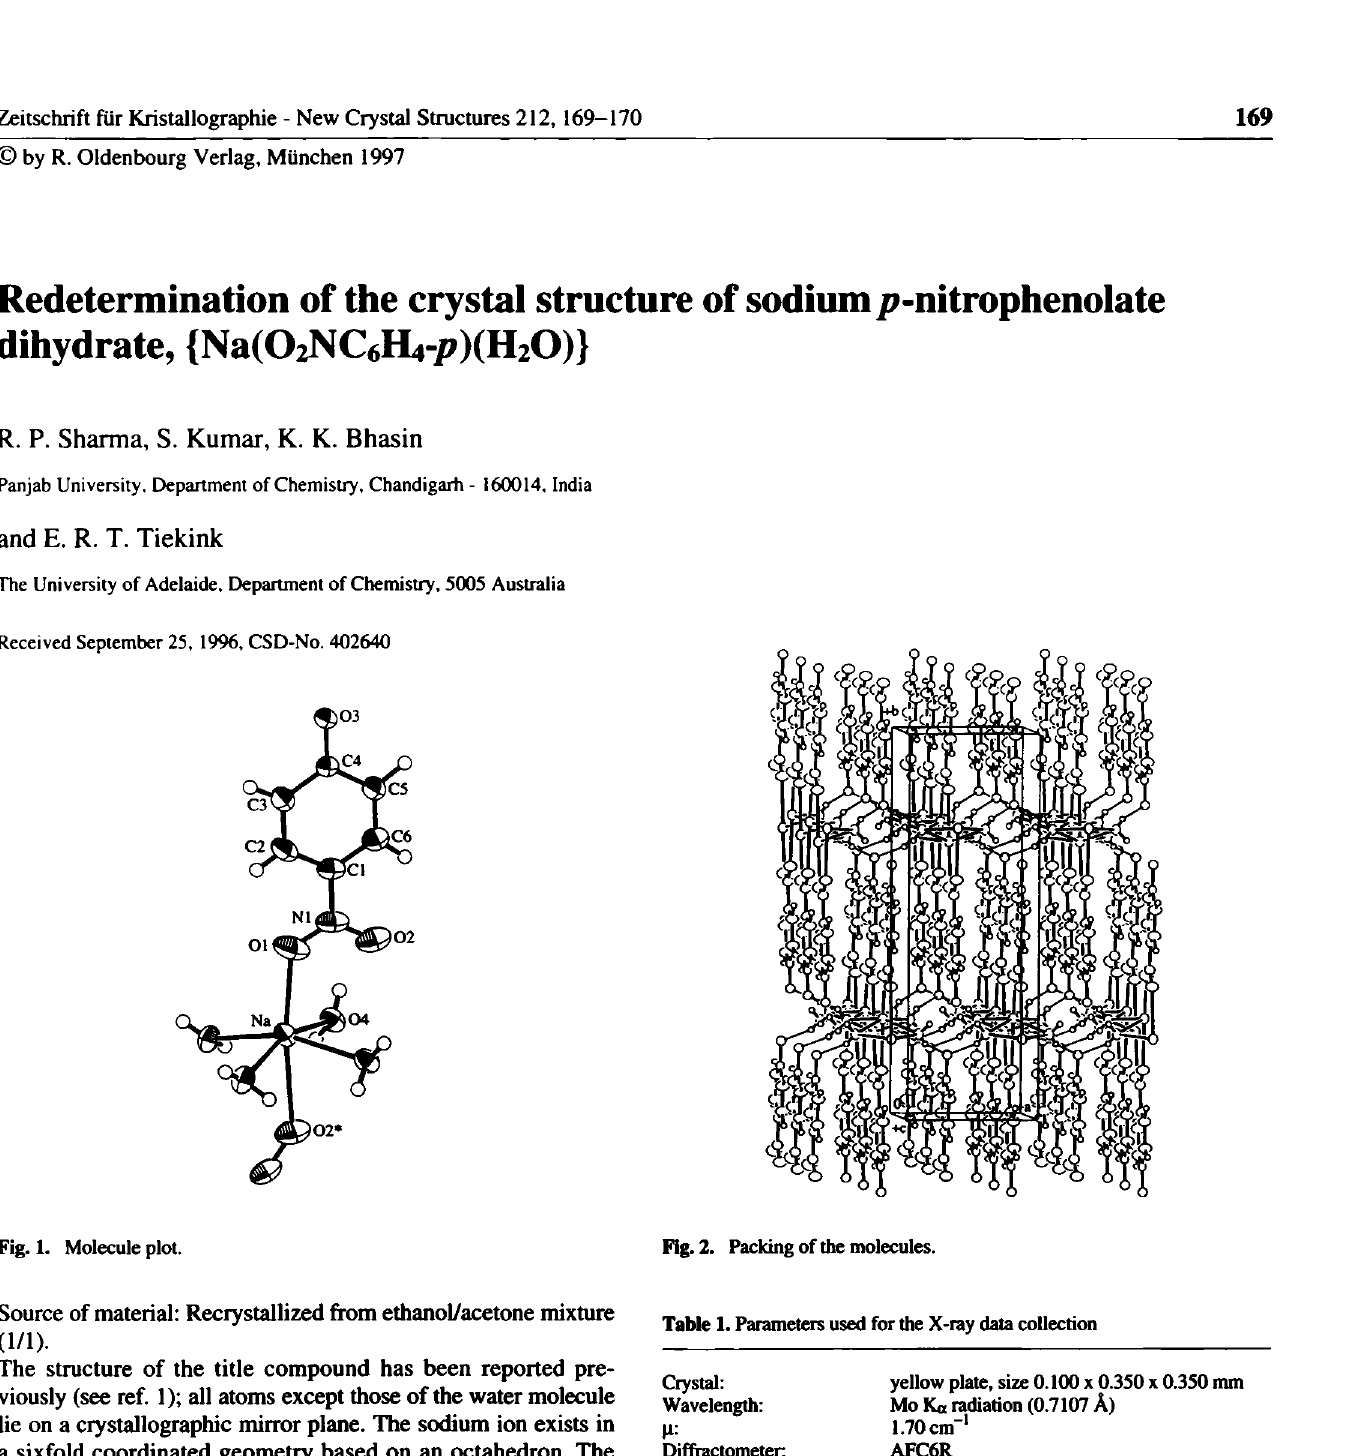
Table 1. Parameters used for the X-ray data collection